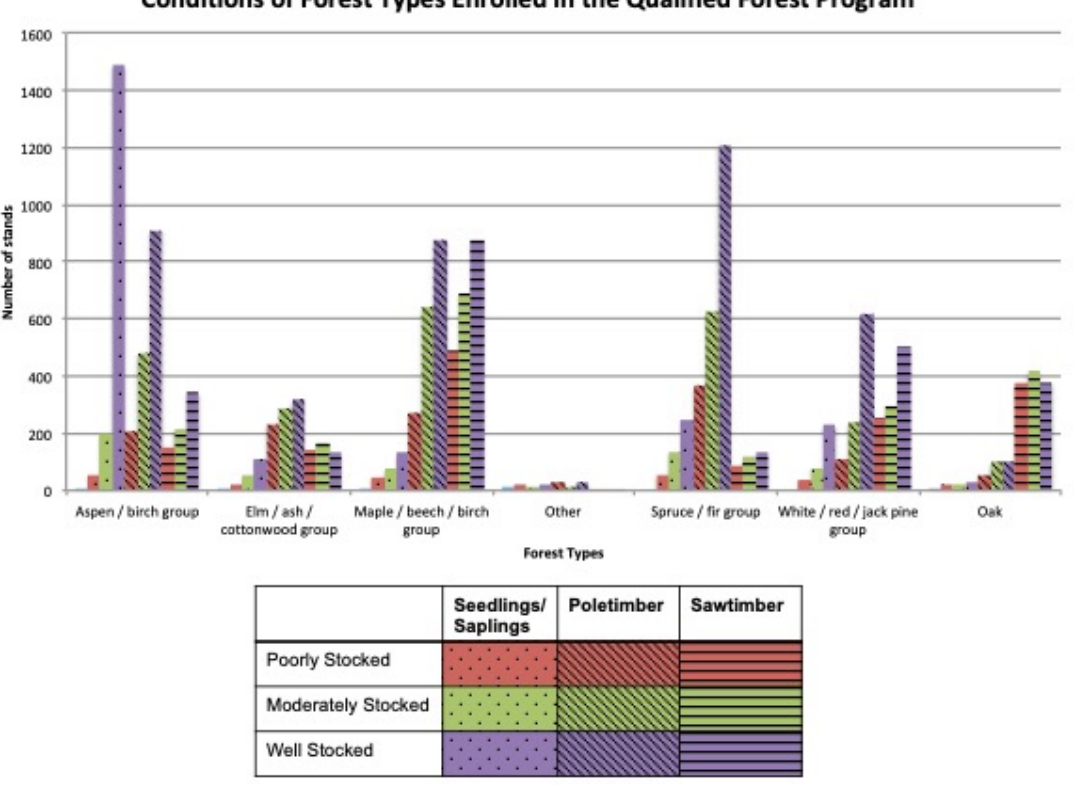
Figure 1. Number of stands within each condition classification, by forest type, enrolled in the Qualified Forest Program. Within the aspen/birch group, 37% of stands are seedling/saplings—well stocked; the most common condition in the group. Poletimber—well stocked (22%) is the second most common stand condition in the group. In the elm/ash/cottonwood group, the majority of stands are poletimber (58%). Only 6% of stands in the maple/beech/birch group are in the seedling/sapling condition. Forty-one percent (41%) of the spruce/fir group is in the poletimber-well stocked condition. Nearly half (45%) of the white/red/jack pine group is in the sawtimber condition. Oak is also quite “top heavy”, in that 79% of the group is in the sawtimber condition (Table 1). Table 1. Forest condition as a percentage of stands within each forest type group.